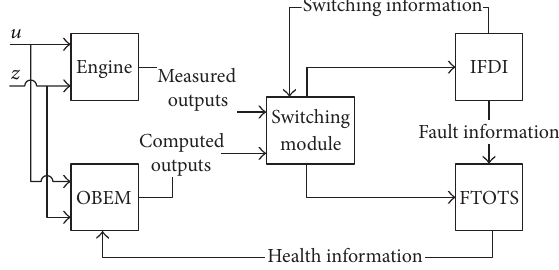
Figure 1: A general fault-tolerant OBEM tuning